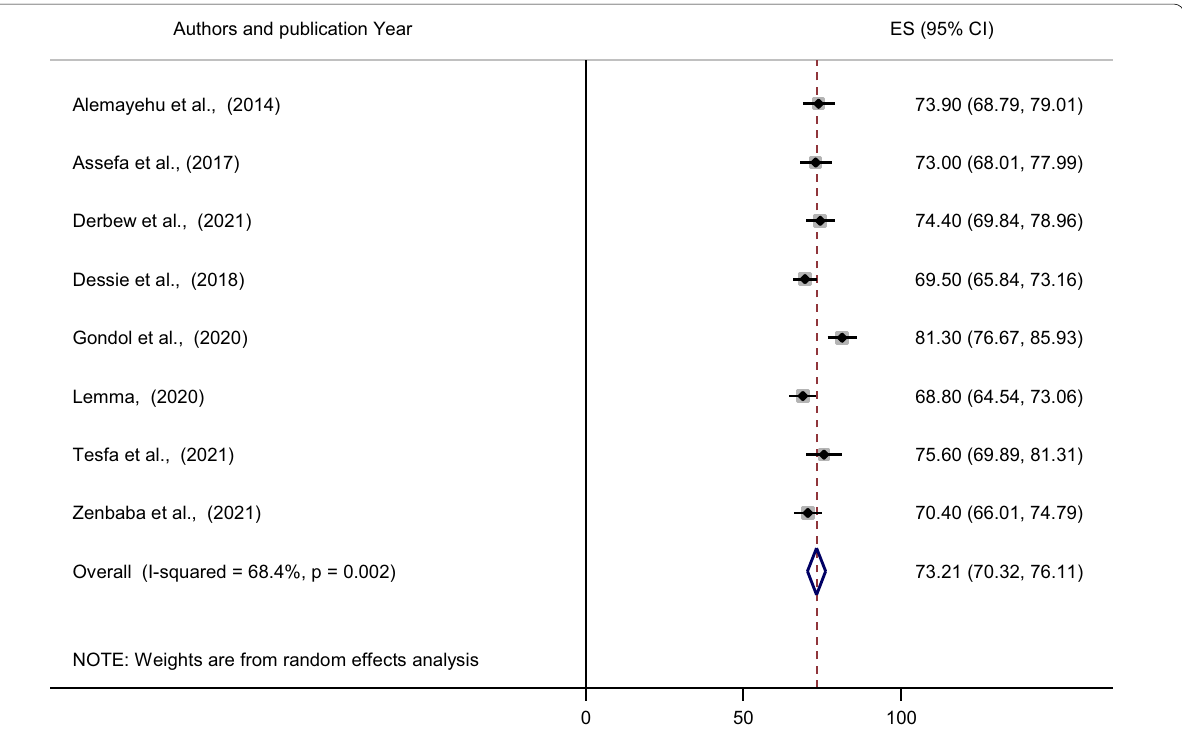
Fig. 2 Forest plot of the pooled prevalence of computer vision syndrome among computer users in Ethiopia,